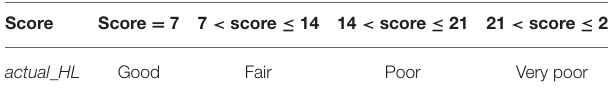
TABLE 1 | Evaluation standard of actual_HL .